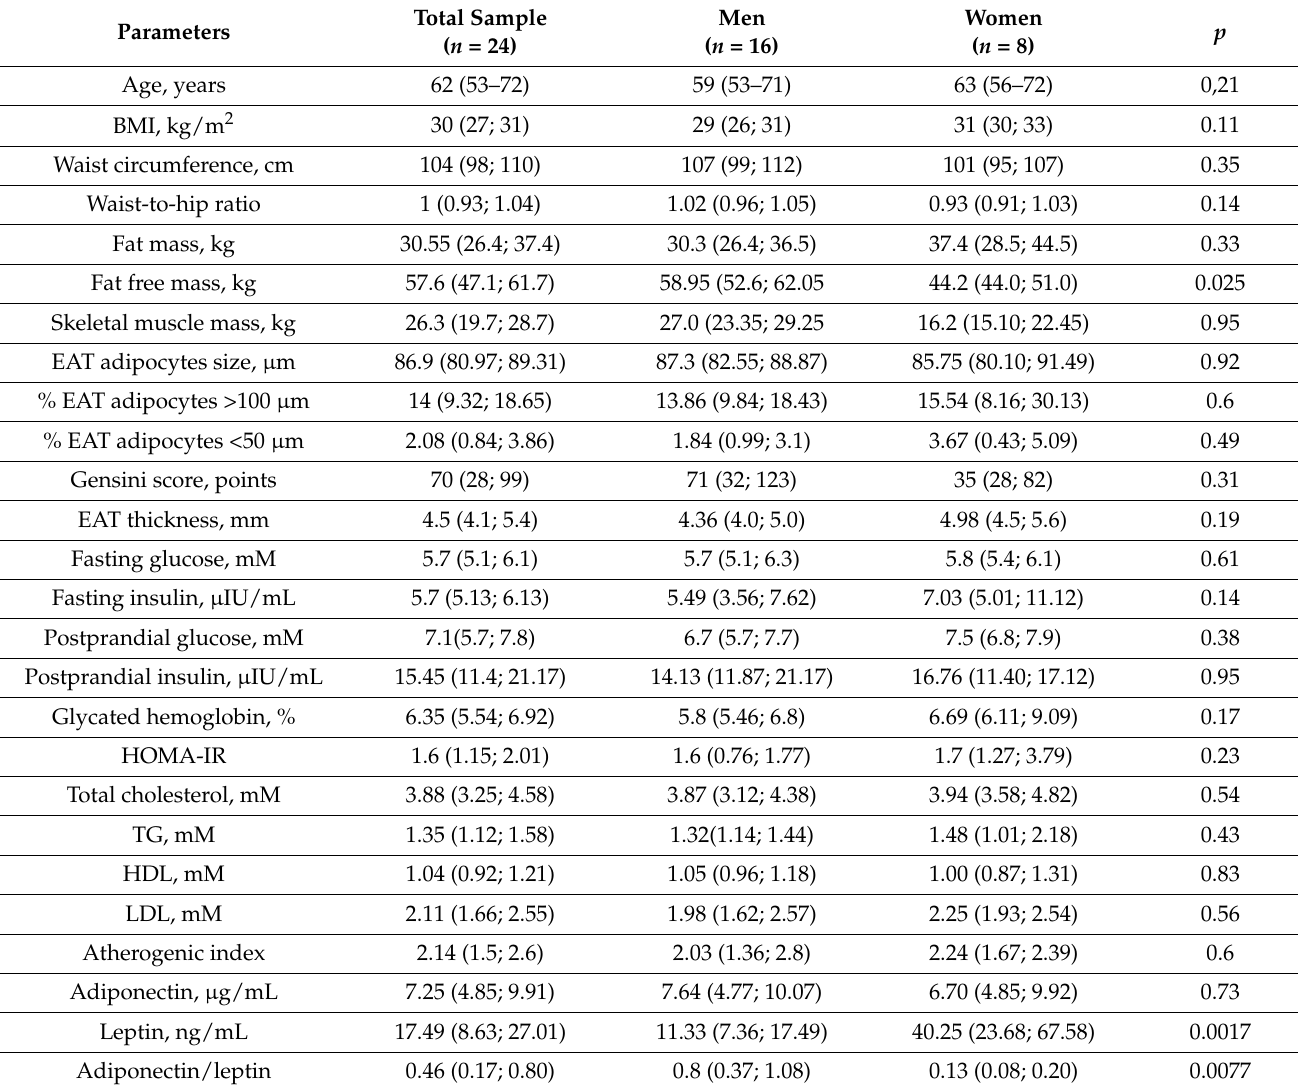
Table 2. Clinical characteristics of coronary artery disease (CAD) patients depending on gender.